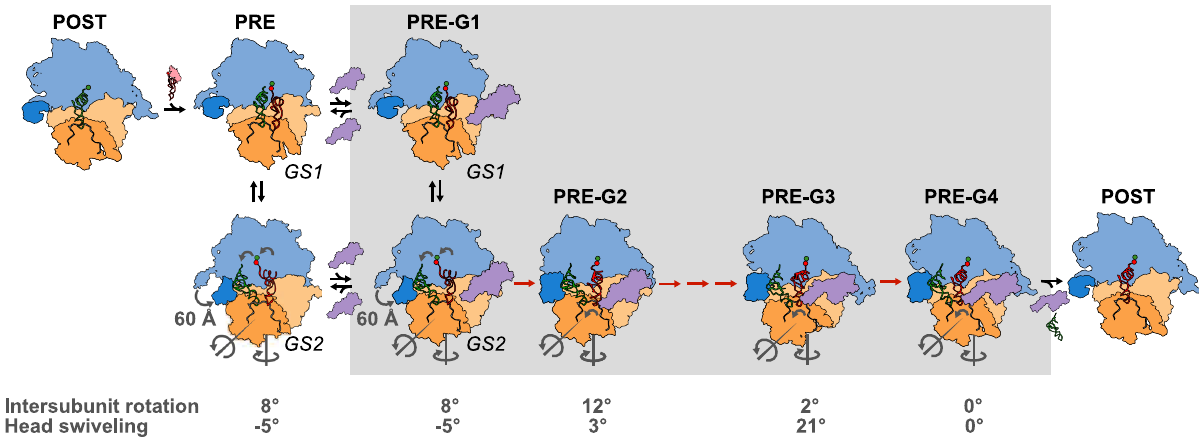
Fig. 7 Structure-based mechanistic model for SufB2 -induced + 1 frameshifting. A SufB2 -TC uses triplet anticodon-codon pairing in the 0-frame at a CCC- C motif, undergoes peptide-bond formation, and enables the resulting PRE complex to undergo a GS1 → GS2 transition, all with rates similar to those of ProL -TC. During the GS1 → GS2 transition, the 30S subunit rotates relative to the 50S subunit by 8° in the counter-clockwise ( + ) direction along the black curved arrow 38 ; the 30S subunit head swivels relative to the 30S subunit body by 5° in the clockwise ( – ) direction against the black curved arrow; the L1 stalk closes by ~60 Å; and the tRNAs are recon fi gured from their P/P and A/A to their P/E and A/P con fi gurations. EF-G then binds to the PRE complex to form PRE-G1 and subsequently catalyzes a series of conformational rearrangements of the complex (PRE-G1 to PRE-G4) that encompass further counter-clockwise and clockwise rotations of the subunits; severing of decoding center interactions with the anticodon-codon duplex in the A site; counter- clockwise and clockwise swiveling of the head and the associated opening and closing of the E-site gate; opening of the L1 stalk; and recon fi gurations of the tRNAs as they move from the P and A sites to the E and P sites. It is during these steps, shown in red arrows within the gray shaded box, that SufB2 impedes forward and/or reverse swiveling of the head and the associated opening and/or closing of the E-site gate, facilitating + 1 frameshifting. Next, EF-G and the deacylated tRNA dissociate from PRE-G4, leaving a POST complex ready to enter the next elongation cycle. The cartoons depicting PRE-G1(GS1) and PRE-G1(GS2) were generated using Biological Assemblies 2 and 1, respectively, of PDB entry 4V9D. Due to the lack of an A-site tRNA or EF-G in 4V9D, cartoons of the A- and P-site tRNAs from the previous structures 1 were positioned into the two assemblies using the P-site tRNAs in 4V9D as guides and a cartoon of EF-G generated from 4V7D was manually positioned near the factor binding site of the ribosomes. The cartoons depicting PRE-G2, PRE-G3, and PRE-G4 were generated from 4V7D, 4W29, and 4V5F, respectively, and colored as in Fig. 6, with the head domain shown in